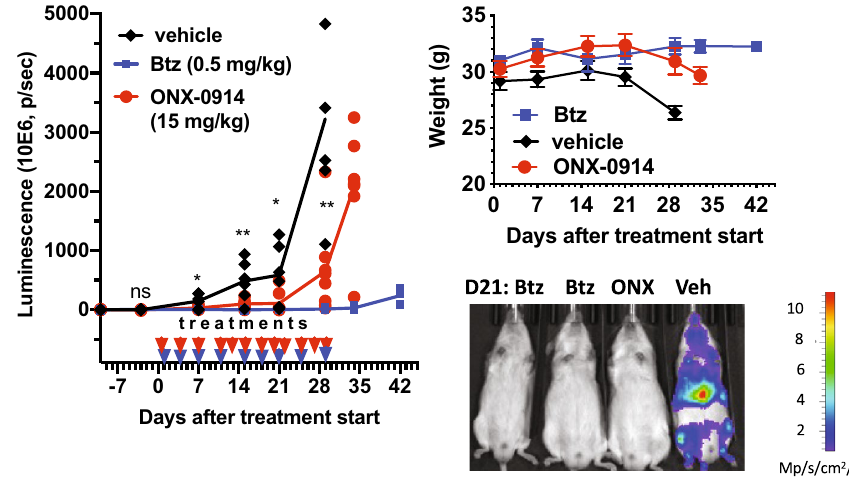
Figure 5. ONX-0914 is active in vivo. NSG mice were injected with SEM-GFP-luc cells 10 days prior to the start of subcutaneous treatments with Btz (n = 8), ONX-0914 (n = 8), or vehicle (10 mM sodium citrate, pH 6.0, 10% Captizol; n = 6). The sample size was based on past experience. The control group originally contained 7 animals, but one animal died of an unrelated cause and was not included in the analysis. ONX-0914 and vehicle- treated groups were compared by unpaired t-test; *0.01 < p < 0.05; **p < 0.01. Lines on the left panel connect mean values. A representative image of the animals on d21 is shown at the bottom panel. All other images are presented on Fig. S5.